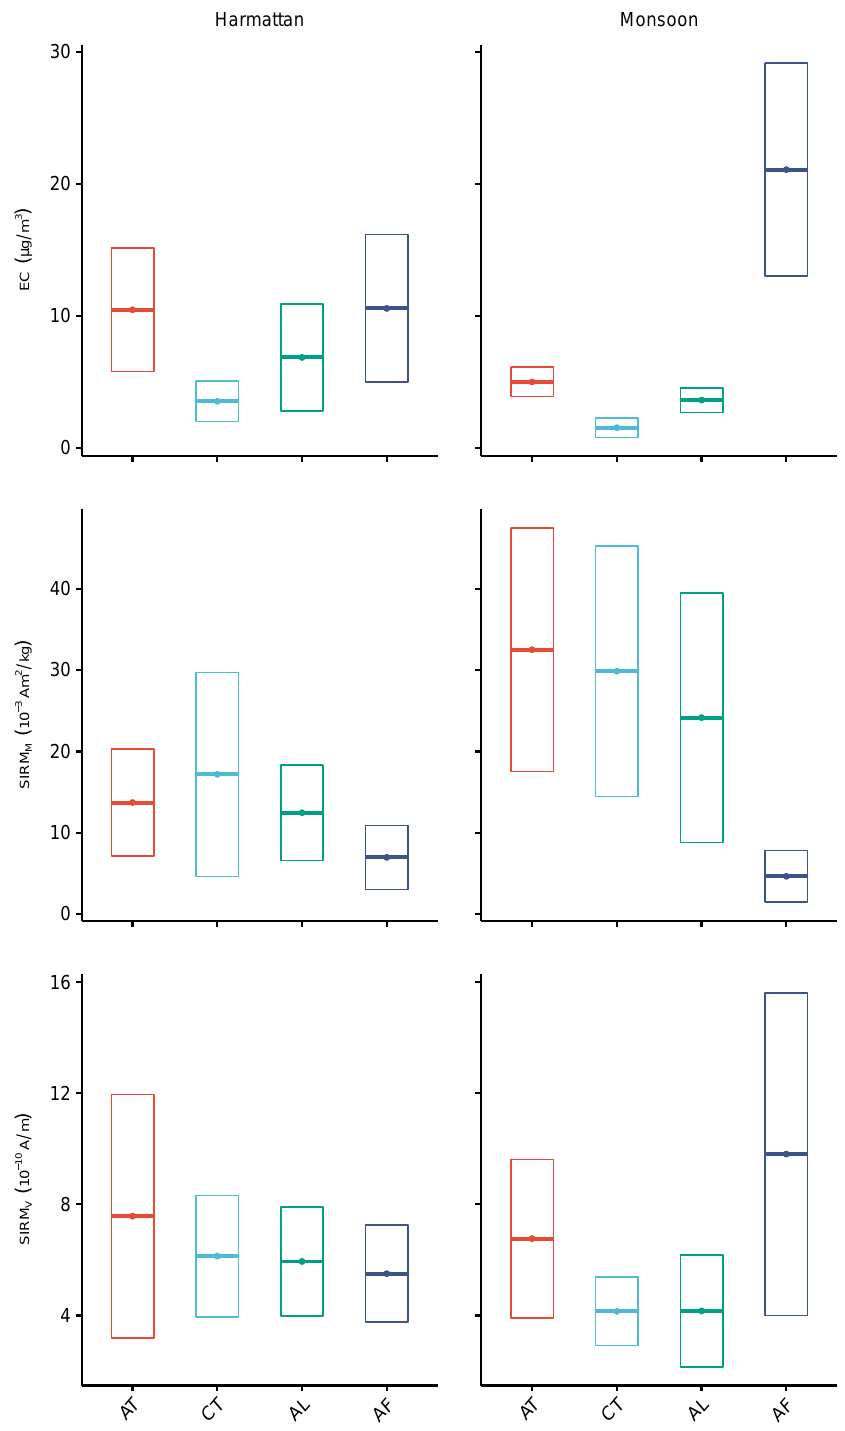
Figure 5. EC concentrations and magnetic content in air volume and PM (SIRM V and SIRM M , respectively) for the two characteristic weather events: the Harmattan period (dry season) and the monsoon season. Means (horizontal lines in the center of the square) and standard deviations (size of the square) are